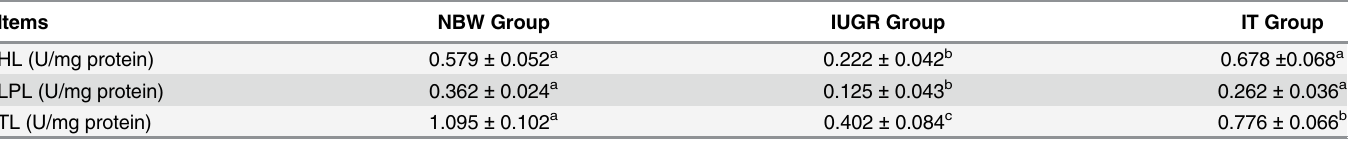
HL, hepatic lipase; LPL, lipoprotein lipase; TL, total lipase, equal to hepatic lipase and lipoprotein lipase activities; Data are expressed as mean ± SEM, n = 6. SEM, standard error of mean. a,b,c Mean values within a line with different superscript letters were signi fi cantly different ( P < 0.05). NBW, piglets with normal birth weight that were fed with basic milk diets; IUGR: piglets with intrauterine growth retardation that were fed with basic milk diets; IT, piglets with intrauterine growth retardation that were fed with diets supplemented with 0.1%